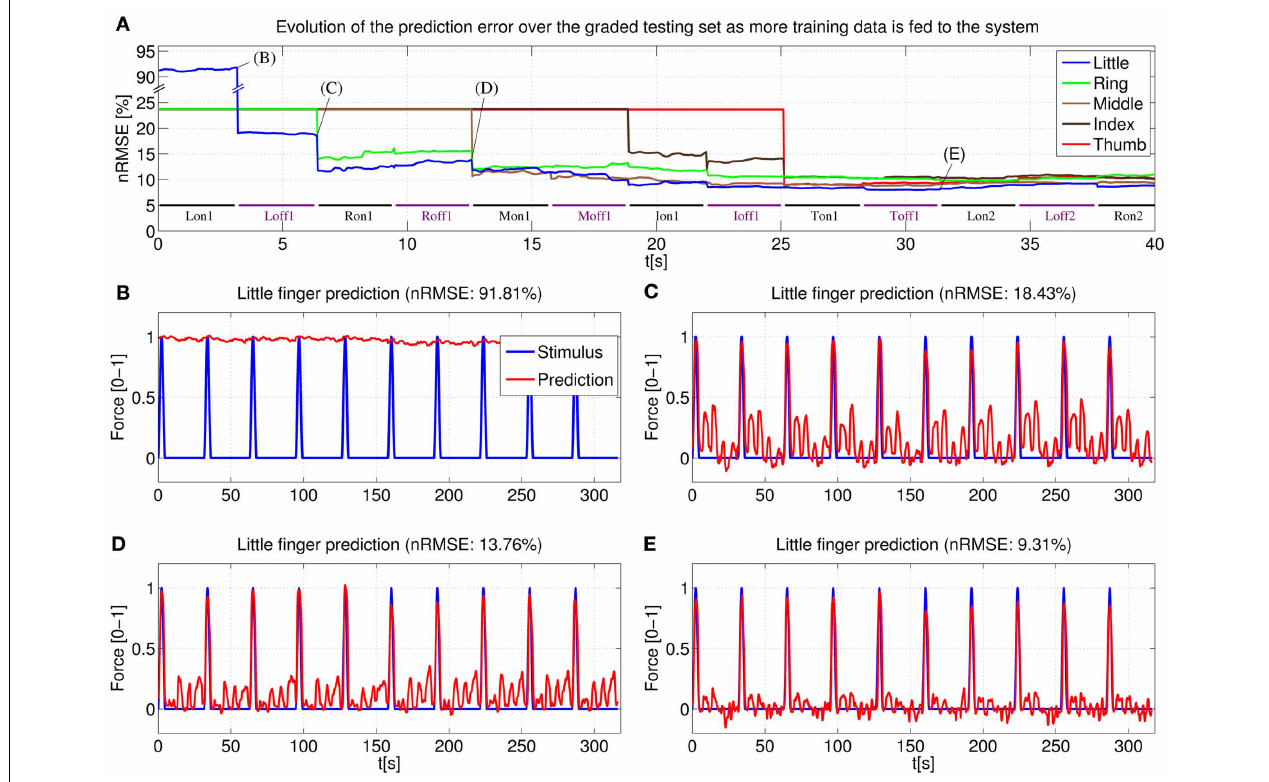
FIGURE 11 | System learning process for a typical subject. (A) Evolution of the prediction error evaluated over the two graded sessions (GR1 + GR2) as the system is fed on-off training data; (B–E) Little finger: stimulus target signal and force prediction at the training points B, C, D, and E (see A ).